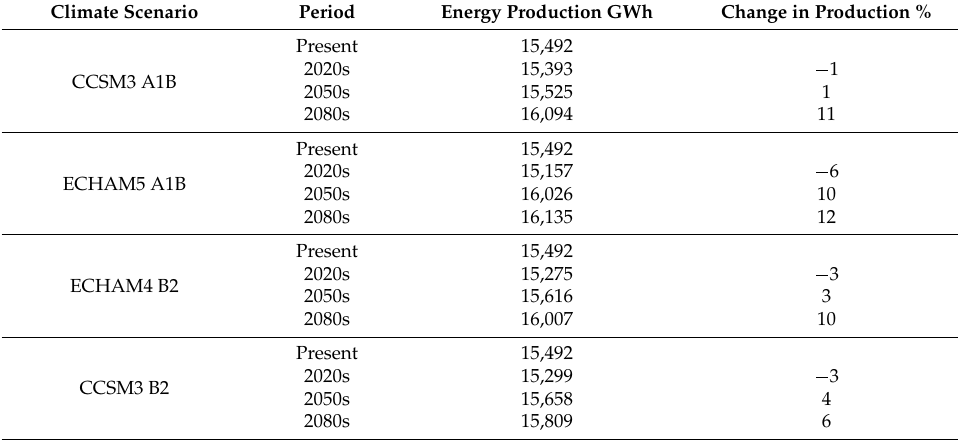
Table 5. Simulation results of the power system and the changes due to climate change for both the B2 and A1B scenarios